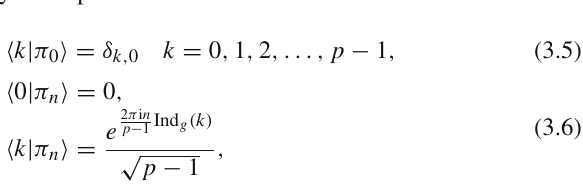
The eigenstates of U ( D A ) are the multiplicative charac- ters, | π 0 (cid:11) , | π 1 (cid:11) , . . . , | π p − 1 (cid:11) , of F ∗